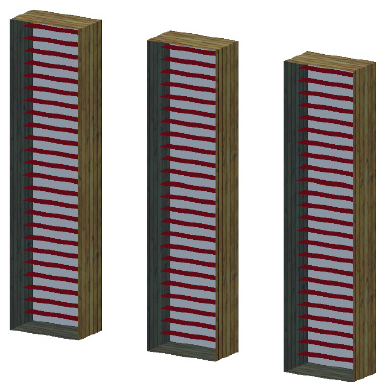
Figure 2. DSF structure, DSF glasses and Venetian-type blind.